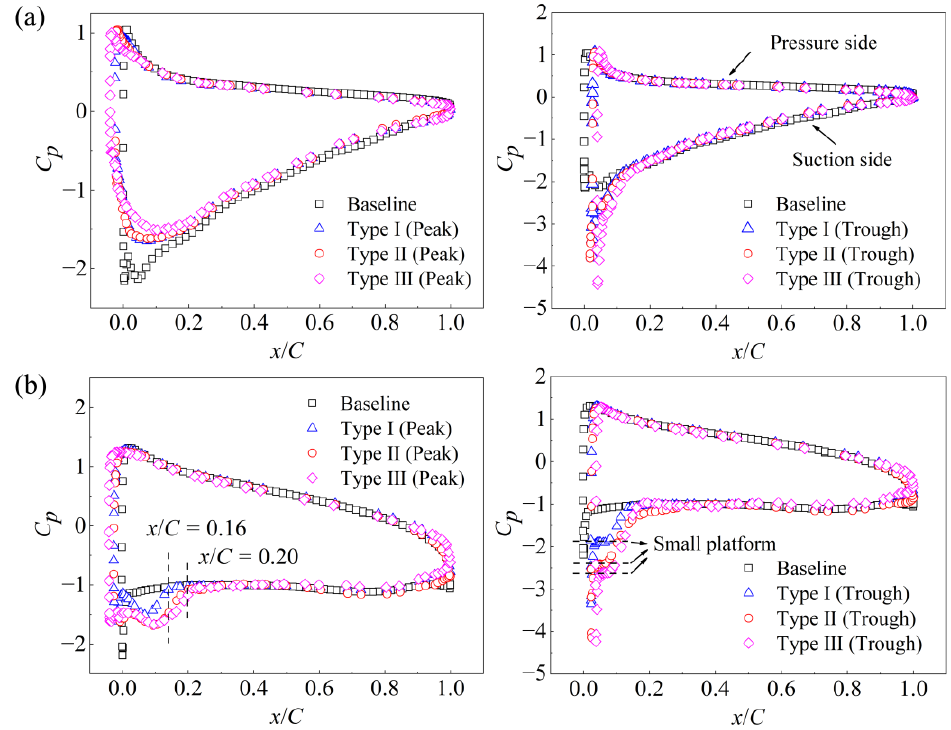
Figure 5. Velocity magnitude distributions of the mid-spans of the baseline hydrofoil and the peak sections of the modified hydrofoils in the XY plane at AOA = 8°, ( a ) and AOA = 25° ( b ).